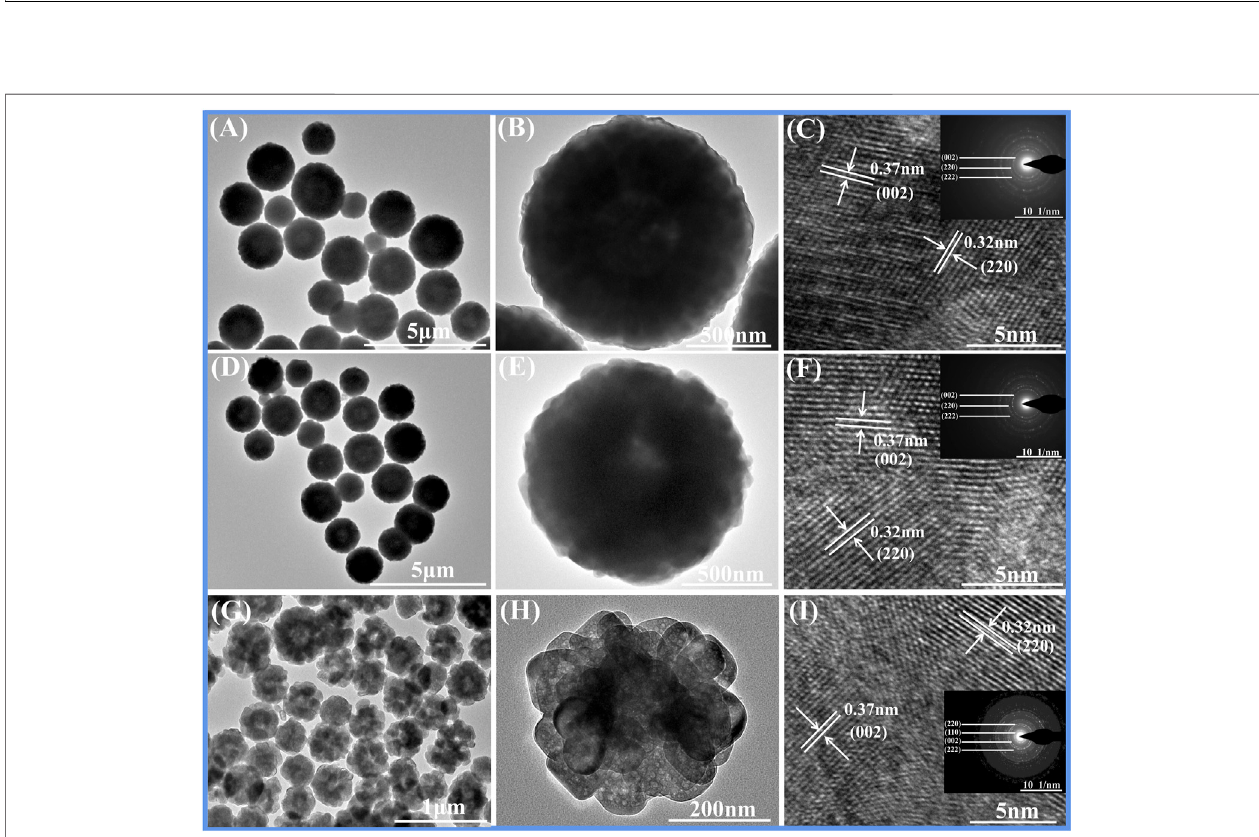
FIGURE 2 | TEM, HRTEM, and SAED characterizations of FeF 3 · 0.33H 2 O: (A – C) P-0, (D – F) P-10, and (G – I) P-20.